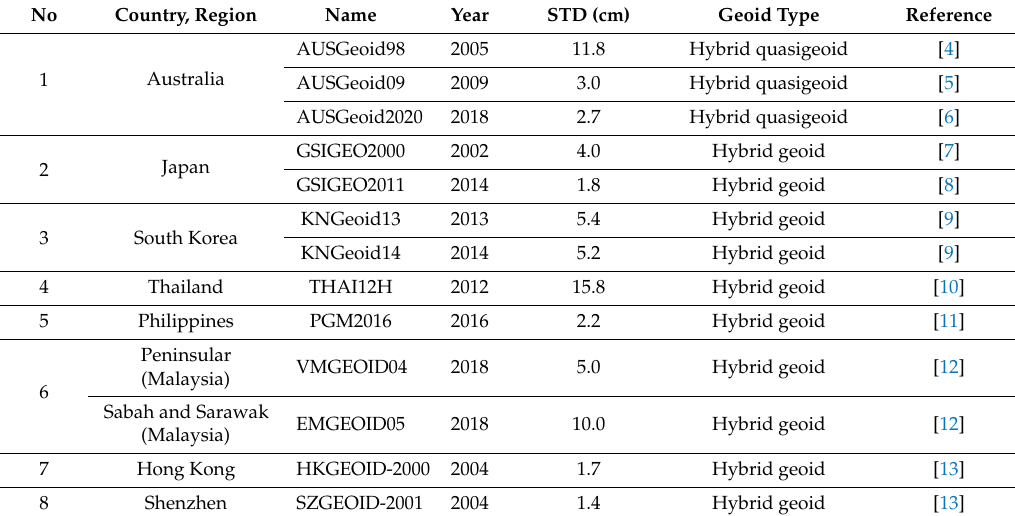
Table 1. Statistics of selected local hybrid geoid or quasigeoid